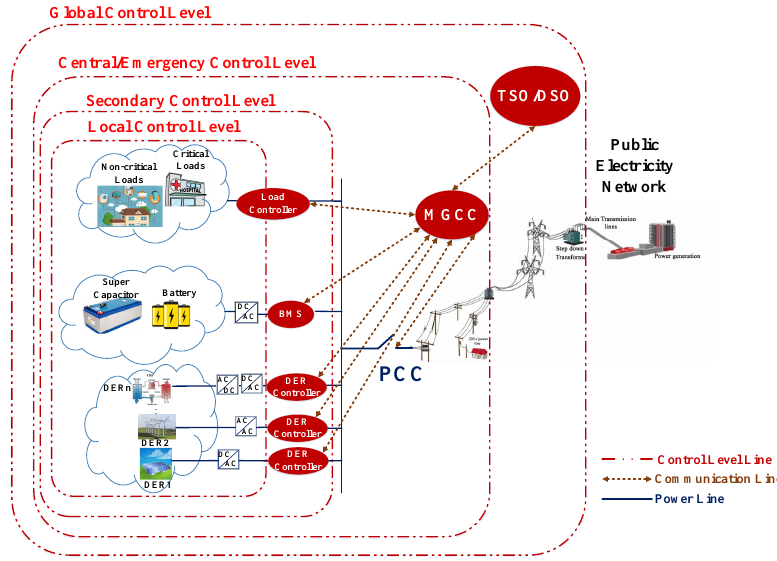
Figure 2. Four different levels of control in the MG. The MG under the central control unit called MGCC interconnects the utility